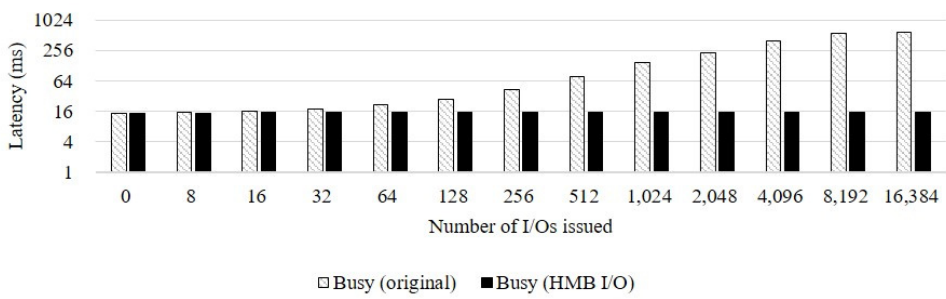
Figure 10. Average I/O latency of Amazon workload.